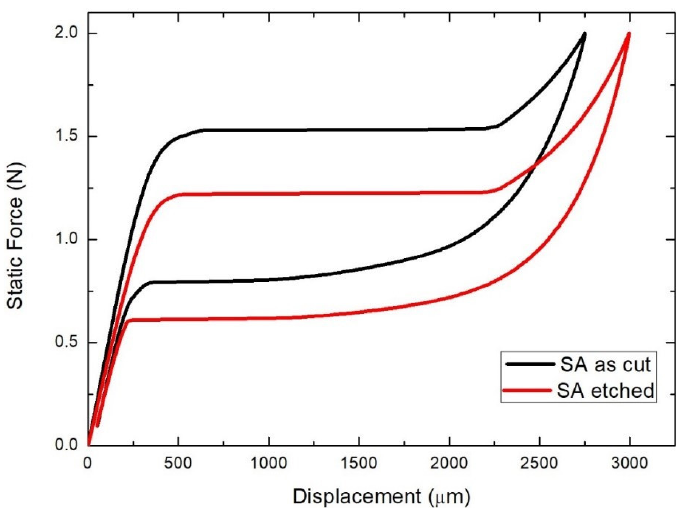
Figure 10. Comparison of static force/displacement curves at 30 °C before and after chemical etch- ing.